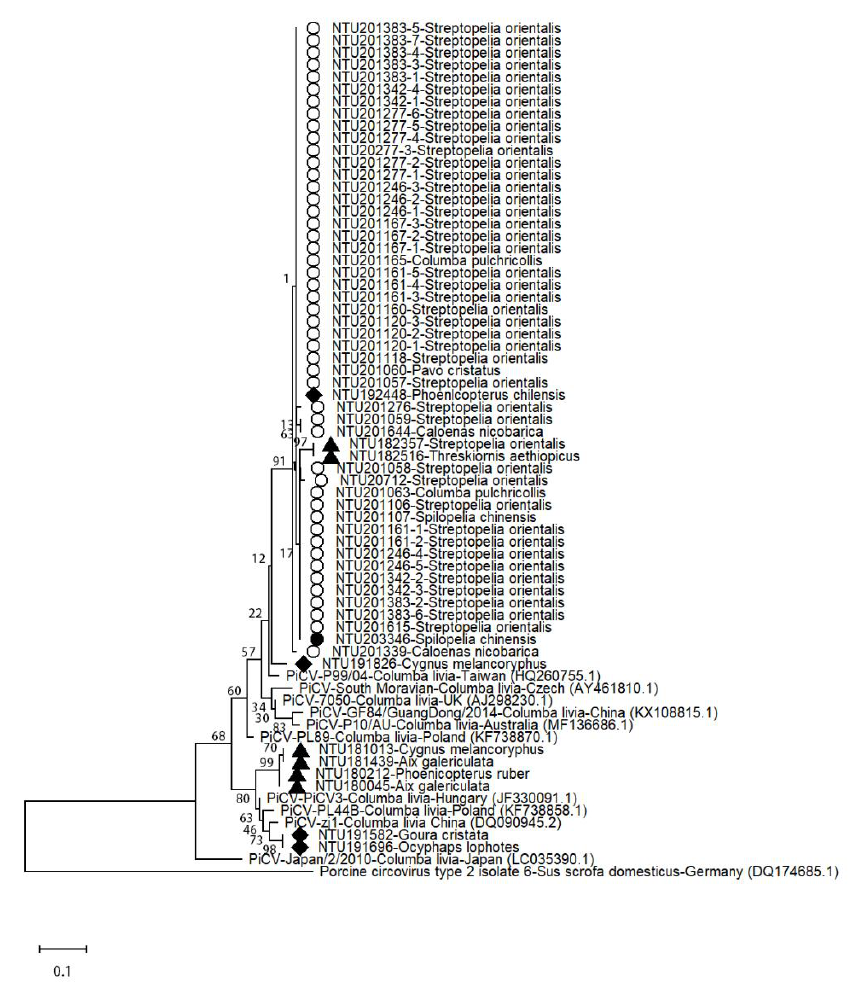
Figure 5. Phylogenetic analysis of pigeon circovirus based on partial cap gene sequences. The information on viral isolates, including first reported animal species and location and GenBank accession number, is shown. The cases labeled with the same indicator are collected in the same year.